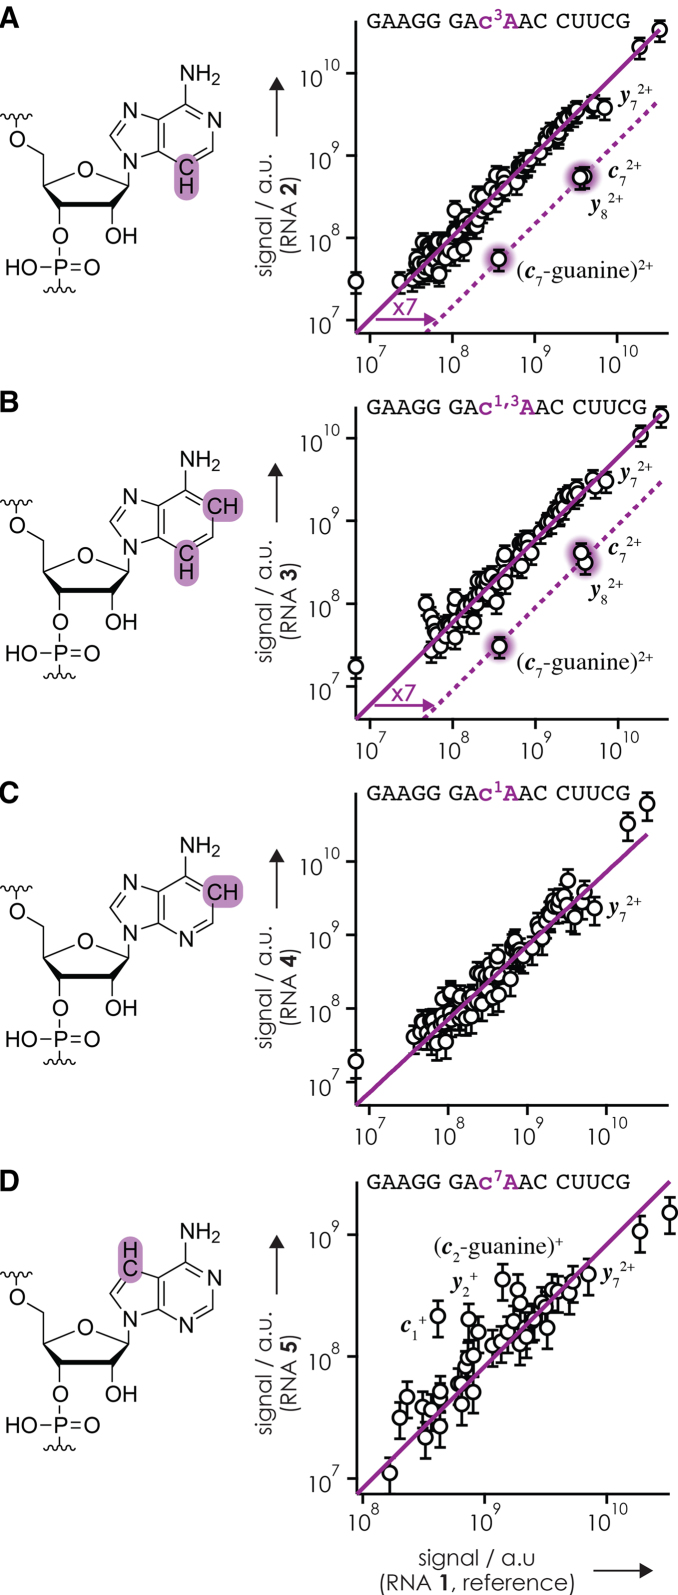
Signals of c and y fragments from CAD (42 eV laboratory frame collision energy) of (M+4H)4+ ions of (A) RNA 2 (c3A at position 8), (B) RNA 3 (c1,3A at position 8), (C) RNA 4 (c1A at position 8) and (D) RNA 5 (c7A at position 8), versus those of the unmodified reference RNA 1 (AAA at positions 7–9). Signals of fragments that were significantly higher in the spectra from CAD of (M+4H)4+ ions of the reference RNA 1 compared to those of the RNA under investigation are highlighted by purple shading.